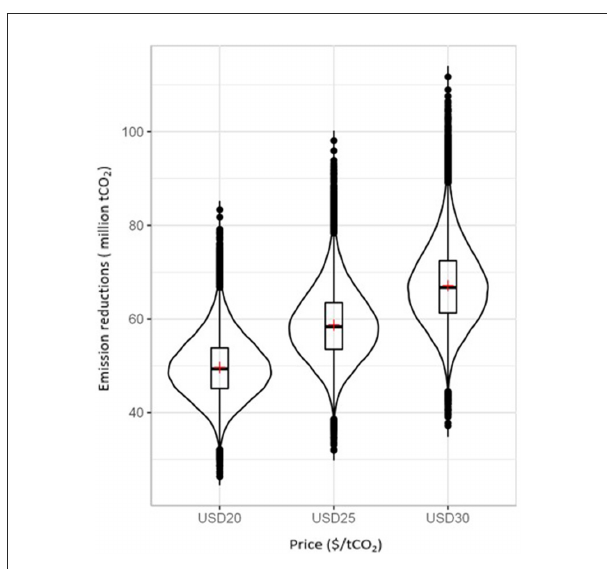
FIGURE2 Distribution of jurisdictional emissions reductions under different carbon prices. Note: The violin plots show a kernel density estimation of the distribution of emission reduction outcomes based on 10,000 trials of a Monte Carlo simulation for each indicated price. The lower and upper edges of the rectangles in the box plots denote the interquartile range (25th and 75th percentiles), with the horizontal lines and crosses denoting the median and mean values,